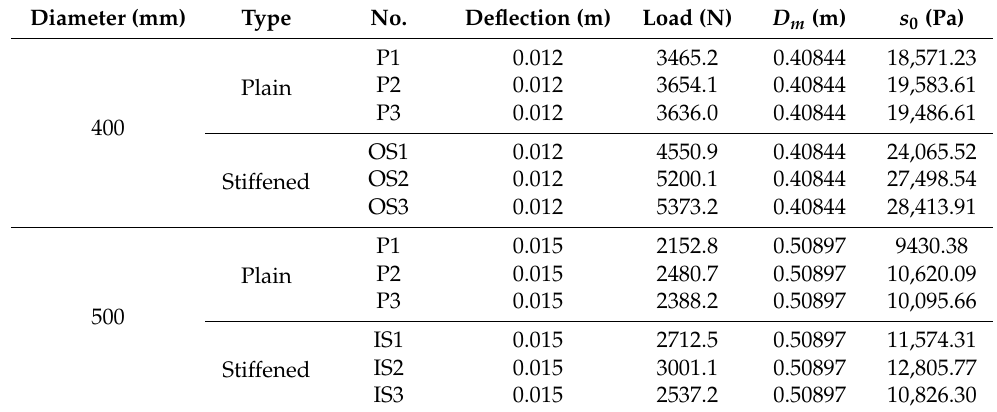
Table 5. Comparison of pipe ring stiffness results under different structural designs at 3% D m displacement